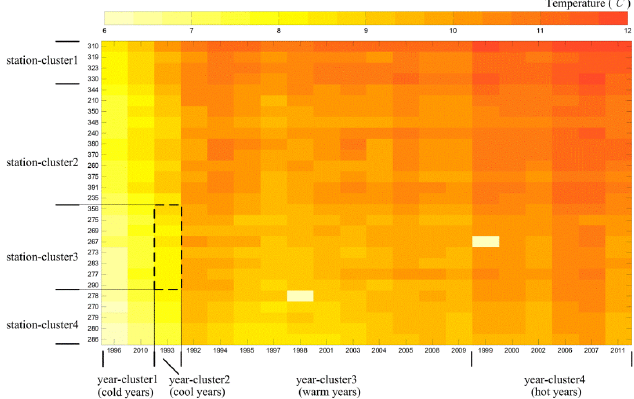
Figure 2. Heatmap to visualize co-clustering result in Dutch yearly temperature dataset (Wu, Zurita-Milla et al.